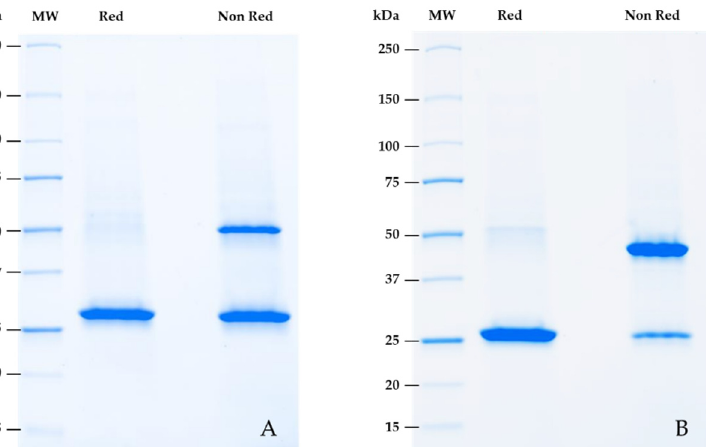
Figure 3. Visualization of purified recombinant Cys-ScFv and Cys-Db. ( A ) F4 Cys-ScFv in reduced (Red) and non-reduced (Non Red) conditions (theoretical MW 27.7 kDa). ( B ) B3.1 Cys-Db in reduced (Red) and non-reduced (Non Red) conditions (theoretical MW 26.3 kDa). MW = molecular weight marker.